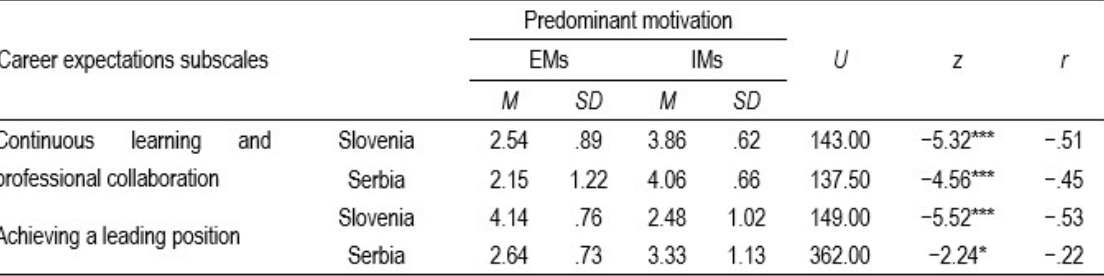
Means, standard deviations, and Mann-Whitney test for individual items of the Career Expectations